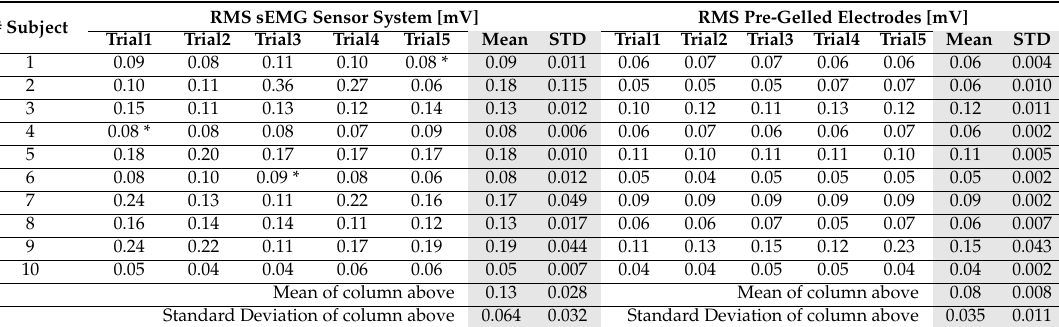
Table A2. Comparison between the RMS of the signal of the first relevant channel detected with the sEMG sensor system and the RMS of a signal detected using a commercial sEMG system based on pre-gelled electrodes. Electrode placement and signal processing complied with the SENIAM recommendations.